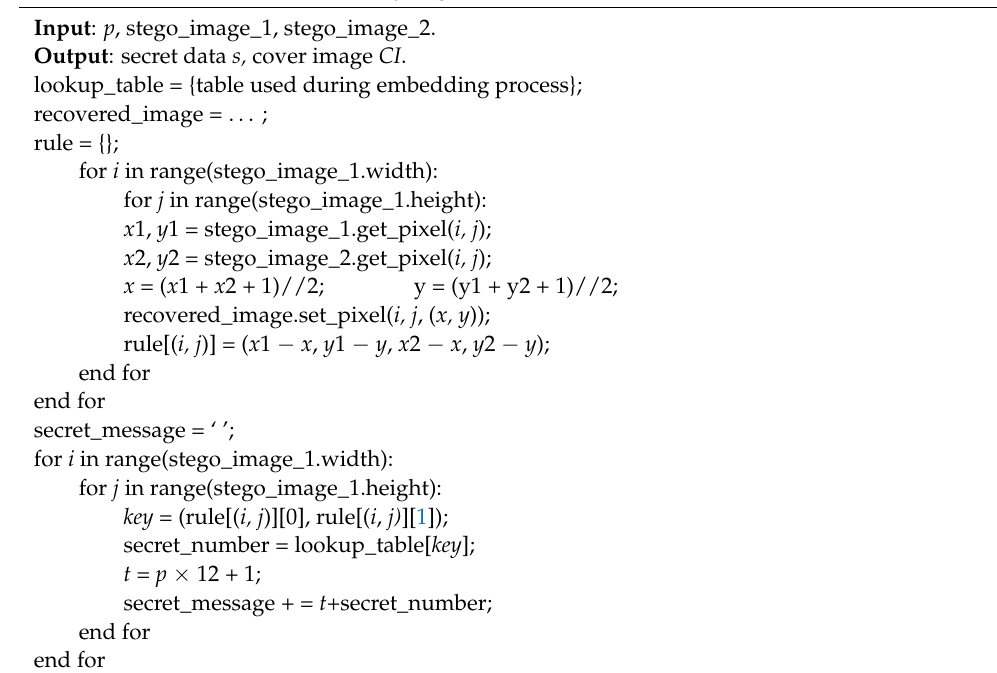
Algorithm 2 Extraction and Recovery Algorithm